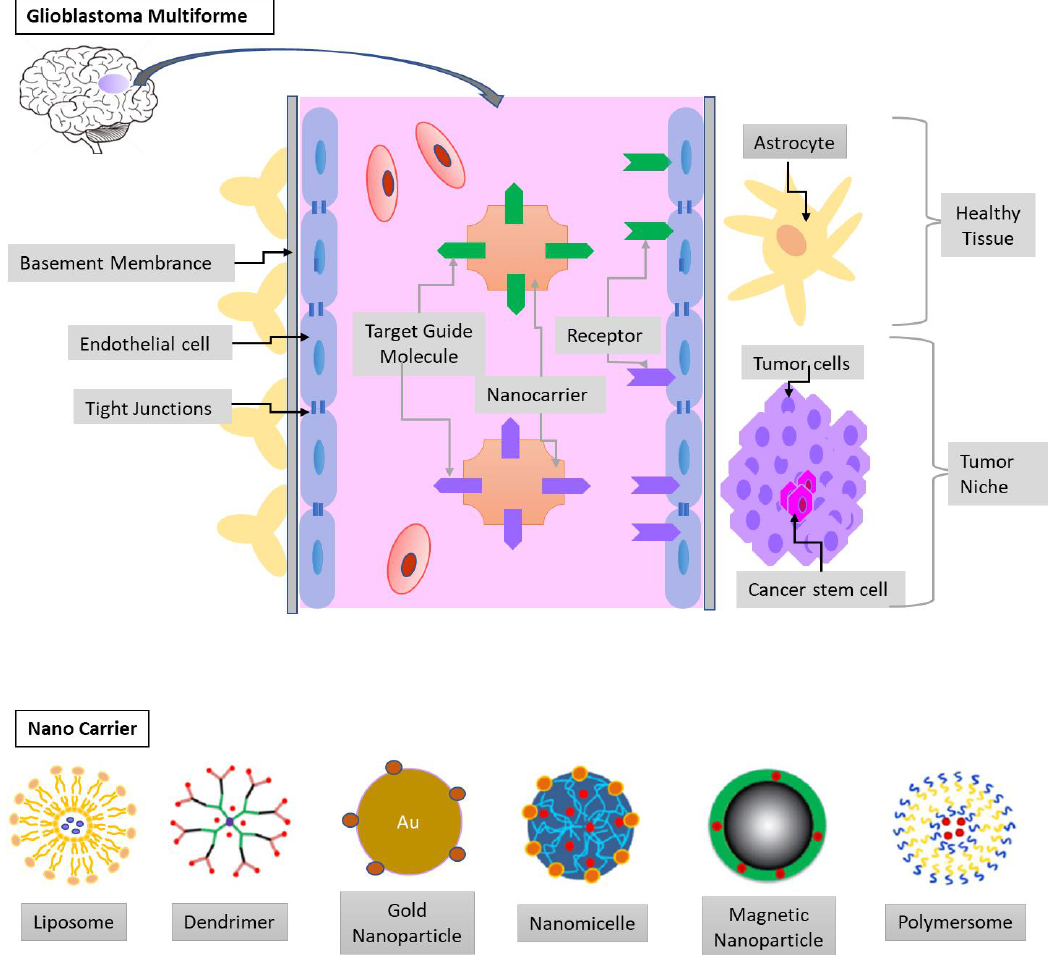
Figure 3. The blood-brain barrier (BBB) and the glioblastoma multiforme (GBM) niche. The endothelia cells, tight junctions, and basement membrane limit the drug delivery to the tumor niche. Therefore, nanocarrier conjugated with target guide molecules and loaded with chemotherapeutic agents can efficiently cross the BBB. The composites of nanocarrier can be liposomes, micelles, dendrimers, metal, and polymeric nanoparticles.